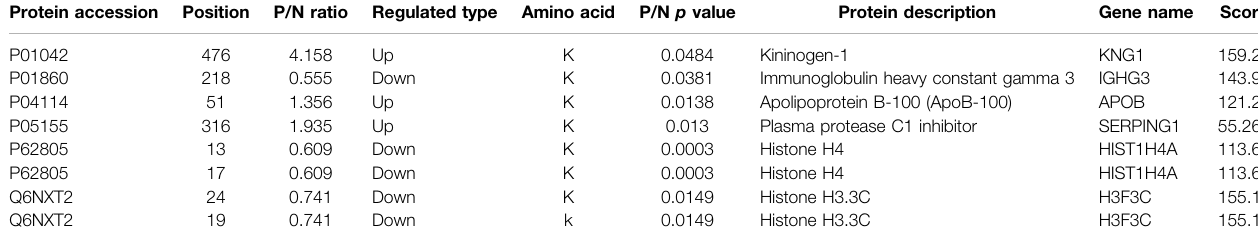
TABLE 1 | Differentially expressed proteins and modi fi cation sites (P/N). Protein accession Position P/N ratio Regulated type Amino acid P/N p value